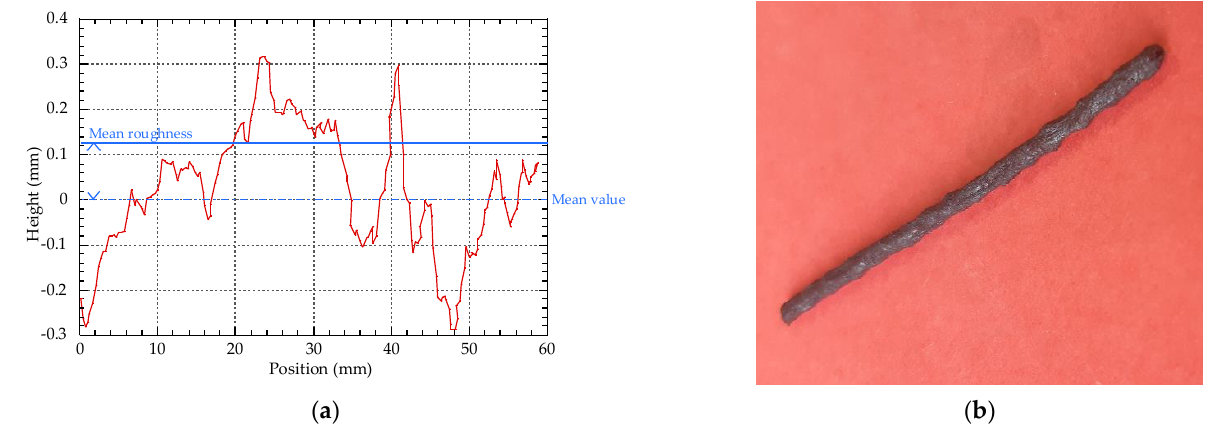
Figure 11. ( a ) Example of the determination of average roughness. ( b ) Example of recycled fibre.